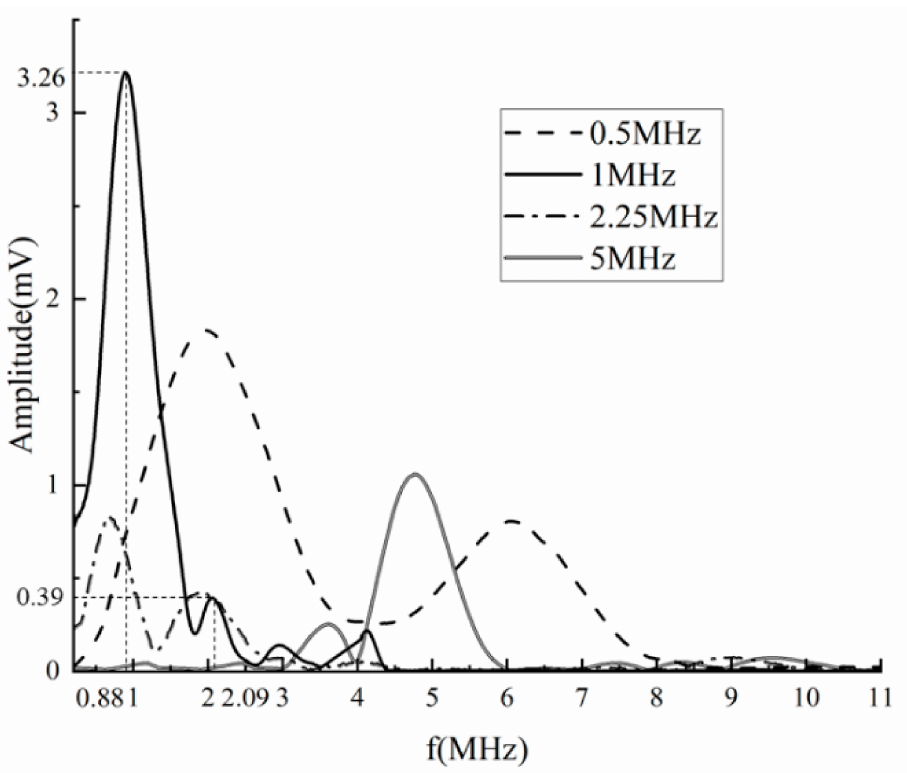
Figure 5. Spectrum of fundamental wave and second harmonic wave in frequency domain obtained by different center frequency